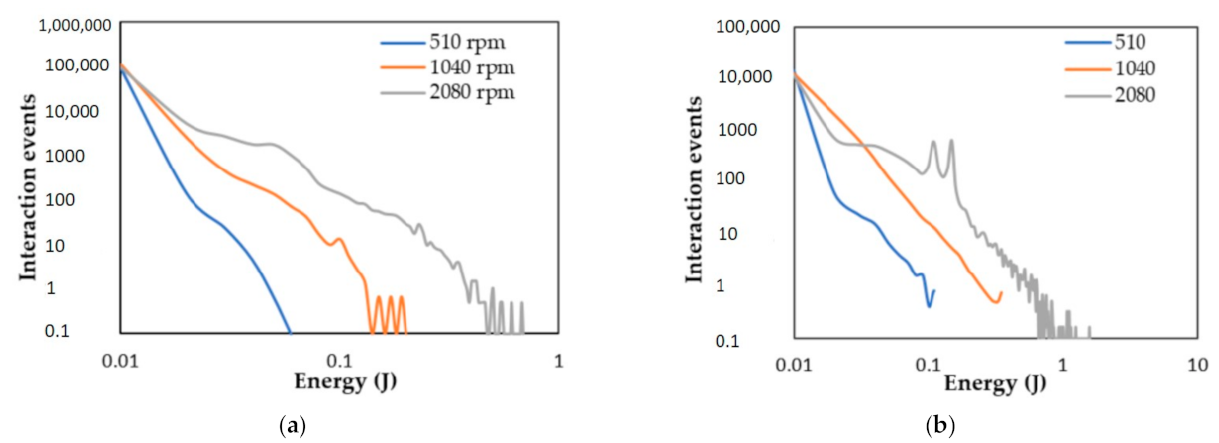
Figure 2. Energy spectra for the effect of rotor speed on single rotor design, particle size ( a ) − 13.2 + 11.2 and ( b ) − 19.0 +